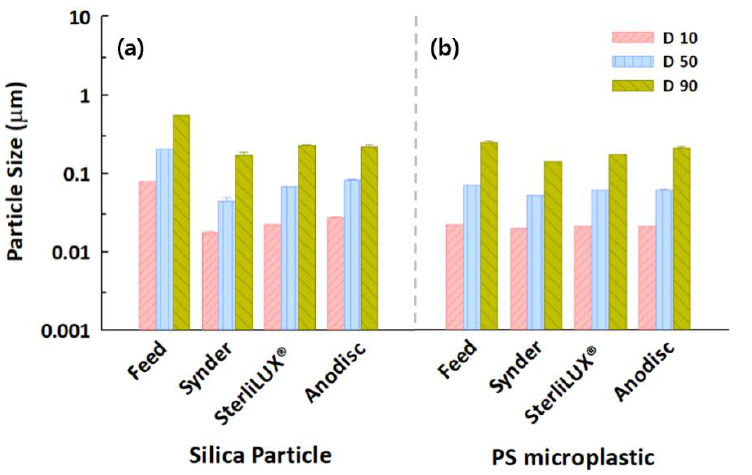
Figure 3. Particle size distributions in feed and permeate water samples after membrane filtration for (a) silica particles and (b) PS microplastics with an average size of 0.1 μm.